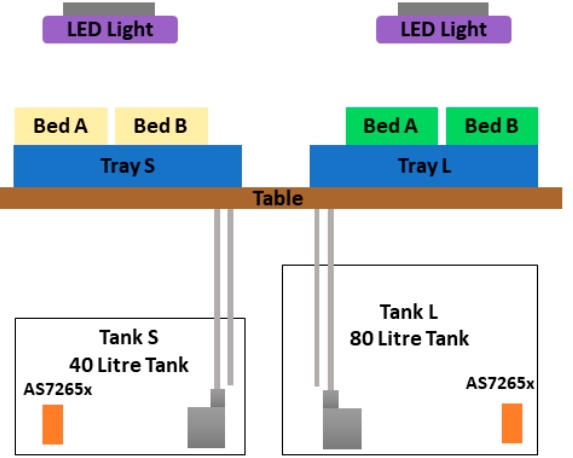
Figure 6. Experimental setup; bed A and B were swapped with each other at day 15.